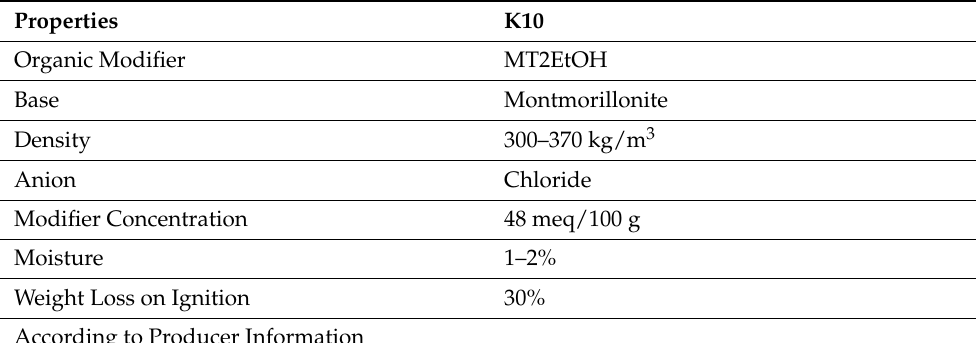
Table 2. Specifications of polyethylene bonded with maleic